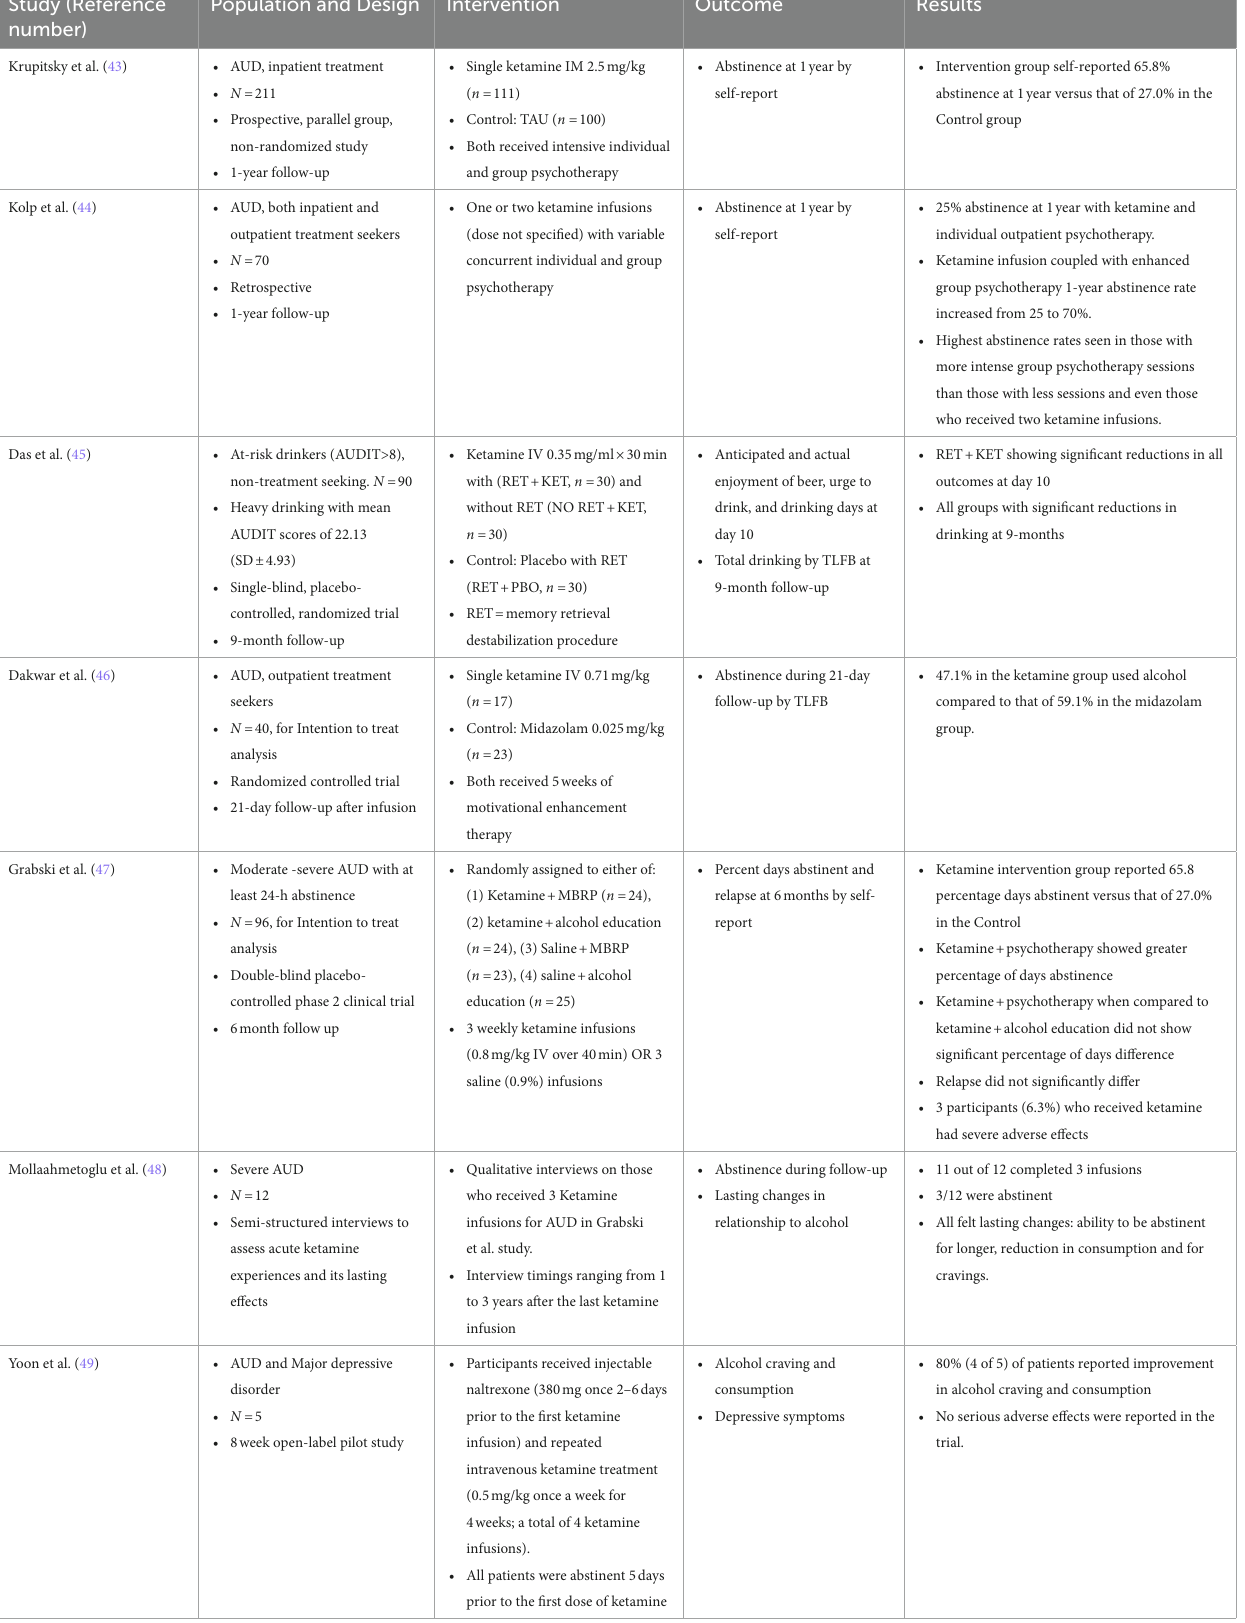
TABLE 2 Summary of studies depicting the use of ketamine for